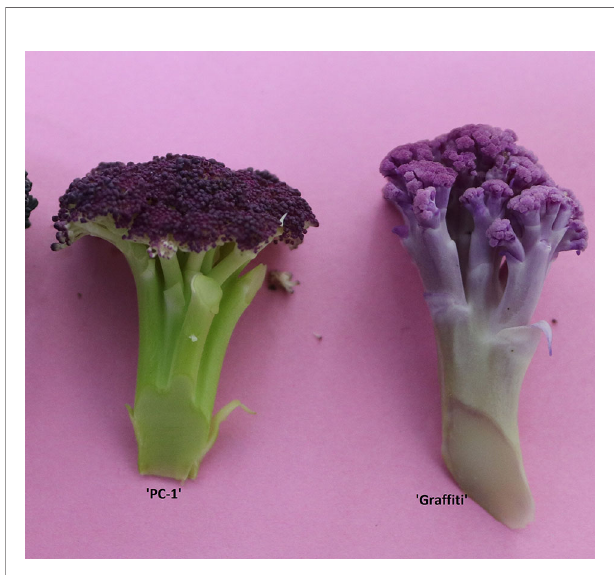
FIGURE 1 | Anthocyanin pigmentation in curd fractions of ‘ PC-1' and ‘ Graf fi